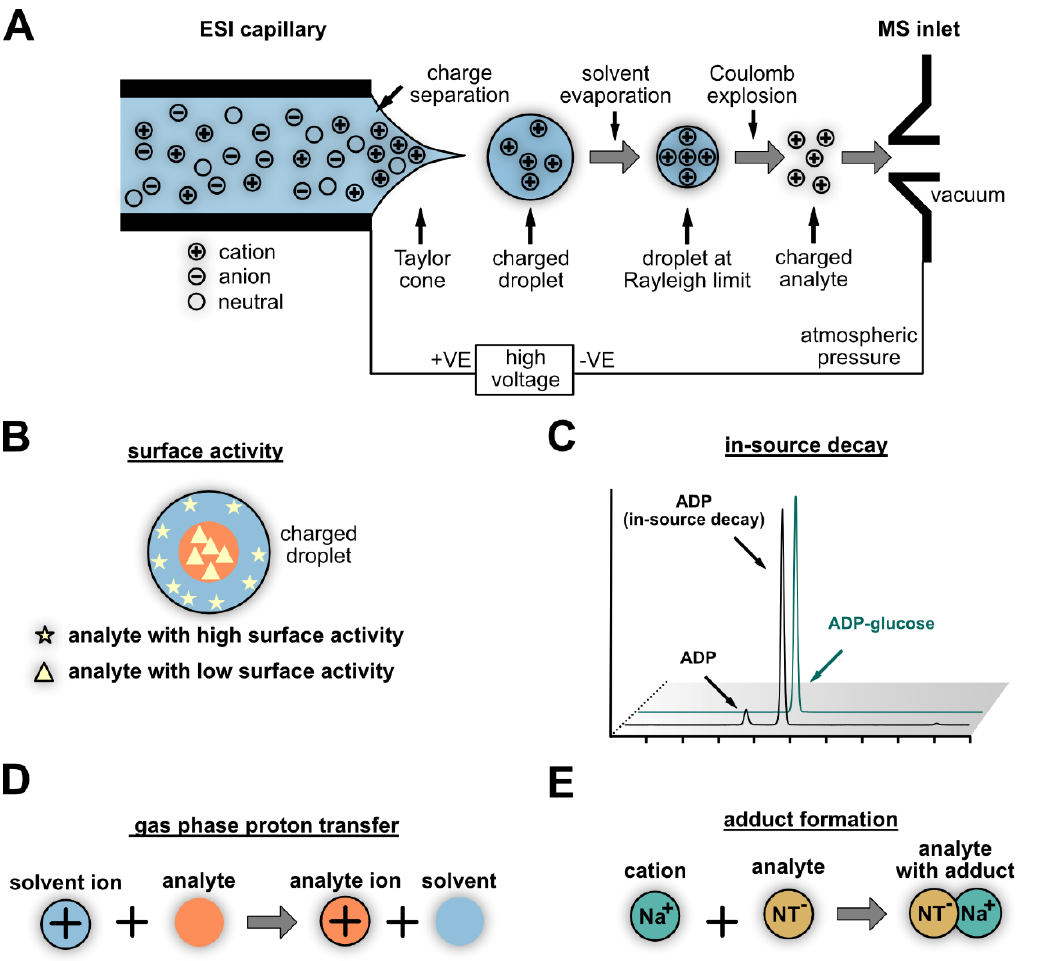
Figure 4. Processes in the electrospray ionization source that result in the formation of ions or influence the sensitivity of detection. ( A ) Charge separation during droplet formation and subsequent solvent evaporation results in charged analytes which can be detected by the mass spectrometer. ( B ) Analytes are not evenly distributed in the droplets. Depending on their surface activity, they locate more in the center (analytes with higher polarity; triangles) or nearer to the surface (analytes with lower polarity; stars) of the droplet. Less polar analytes with strong surface activity have a higher ionization efficiency than more polar analytes in the center of the droplet. ( C ) Decay of the analyte in the source results in signal loss. Adenosine diphosphate (ADP) is chromatographically separated from ADP-glucose in this example, but the fragmentation of ADP-glucose in the source results in the formation of ADP that appears to co-elute with ADP-glucose. If this is not noted, the amount of ADP-glucose can be underestimated ( D ). An additional process leading to ionization is the gas phase proton transfer that is determined by the proton affinities of the solvent, the modifiers, and the analytes. ( E ) The formation of adducts with, e.g., sodium or potassium, often results in the formation of two or more species from the analyte with different masses. Splitting the signal of the analyte usually leads to decreased sensitivity.